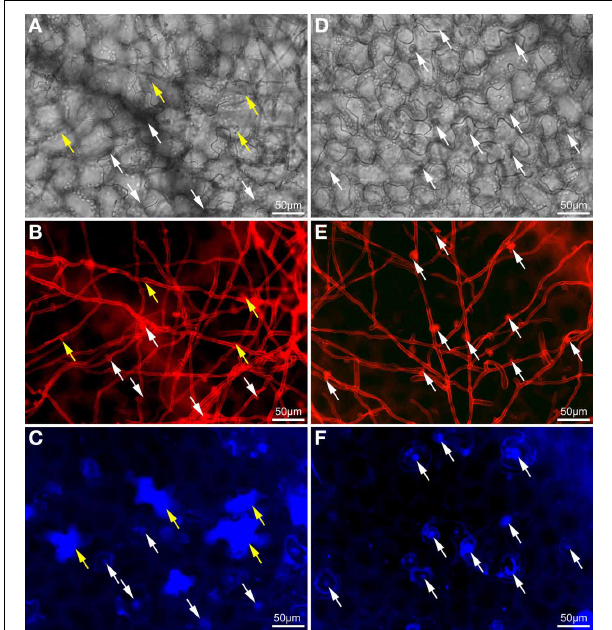
FIGURE 7 | Wild type plants exhibit significantly more dead epidermal cells and less established haustoria as compared to atcep1 mutants upon inoculation with Erysiphe cruciferarum . Microscopic phenotype of powdery mildew attacked cells on Arabidopsis WT (Col0) and the atcep1 knock out mutant (SAIL_158_B06) 5dpi. WT cells show a frequent hypersensitive response (HR)-like reaction of penetrated cells (A–C) whereas no HR-like reaction is observed in the atcep1 mutant (D–F) . (A,D) Brightfield image of the selected areas. (B,E) Fungal structures on the leaf surface and bulbous haustoria marked by white arrows were stained with wheat germ agglutinine-tetramethylrhodamine. (C,F) Callose was stained by methyl blue staining. Punctate methyl blue stained structures show papilla/cell wall appositions and encapsulated haustoria. Completely stained cells marked by yellow arrows indicate an HR-like cell death.